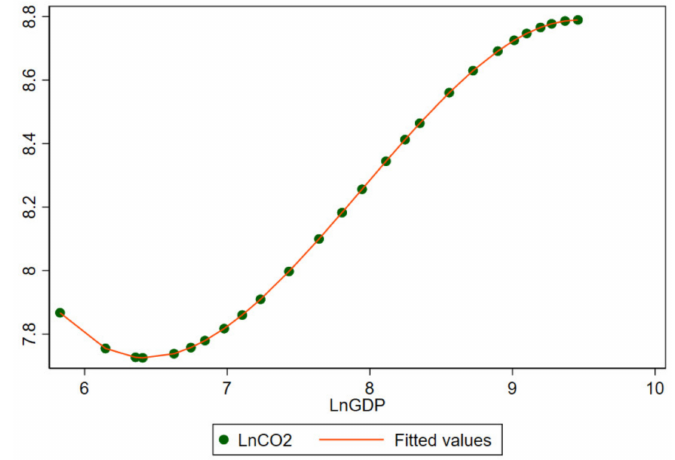
Figure 9. Equation